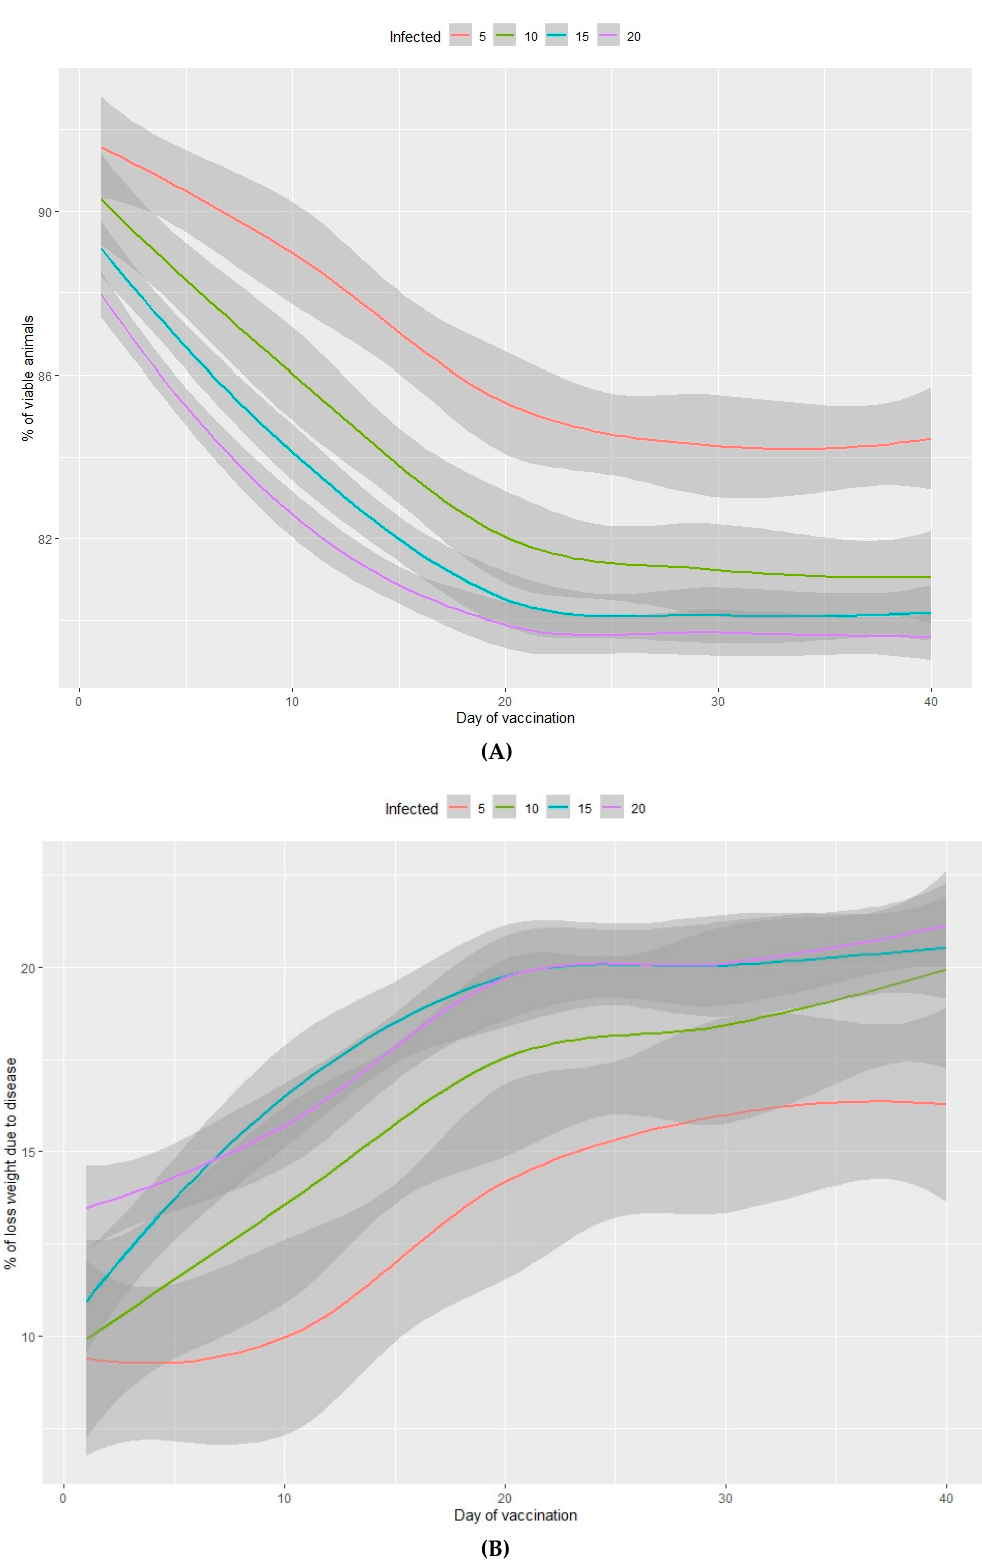
Figure 3. Percentage of viable animals (A) and percentage of total weight lost (B) at the end of the nursery period in relation to the percentage of infected animals (from 5%–20%) and the number of days between infection and vaccination of 100% of the population.